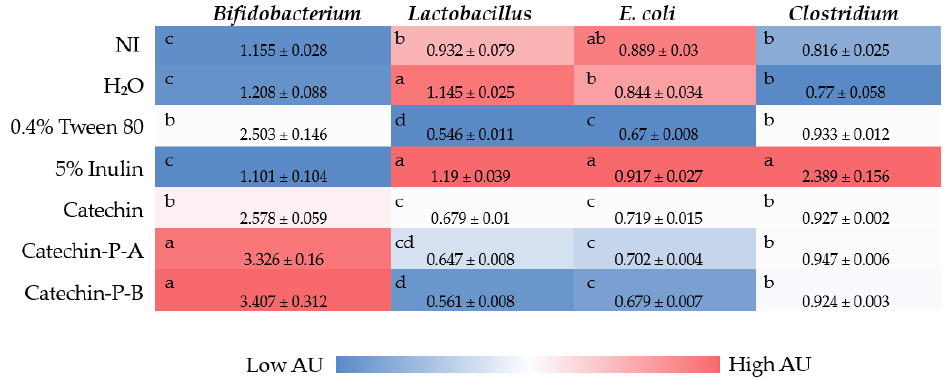
Figure 1. Effects of intra-amniotic injections on cecal genera and species-level bacterial populations (day of hatch). Values are means ± SEM, n = 10. a – d Per bacterial category (in the same column), treatment groups that do not share any letters are significantly different according to a one-way ANOVA with a post hoc Duncan test ( p < 0.05). NI, No Injection; Catechin-P-A, Catechin pentaacetate; Catechin-P-B, Catechin pentabutanoate.